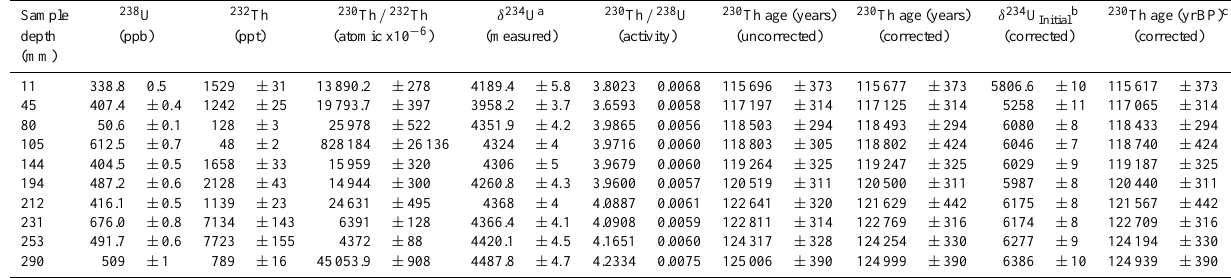
Table 1. 230 Th dating results of P10-H1.